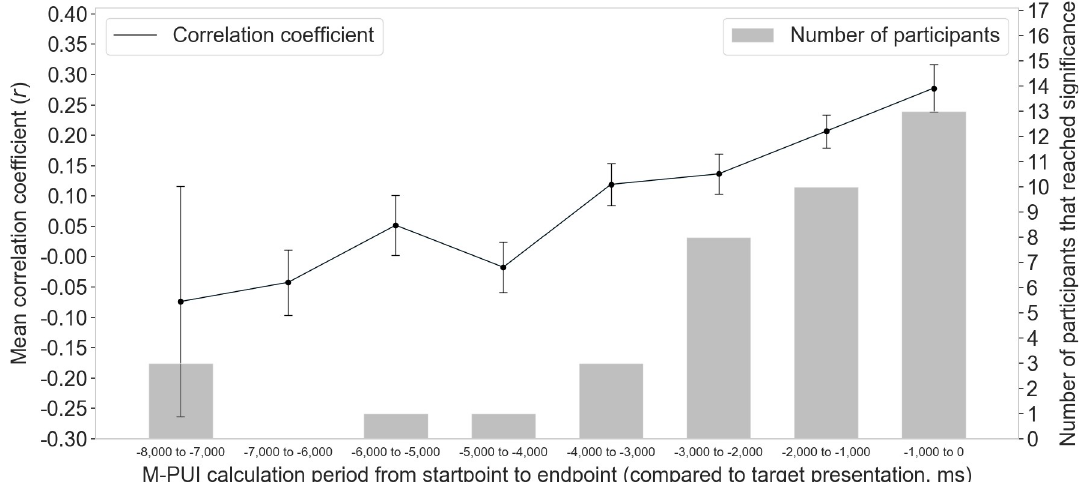
Fig 9. Mean correlation coefficients between normalized M-PUI and normalized RTs for different time points and numbers of participants whose correlation coefficients reached significance.